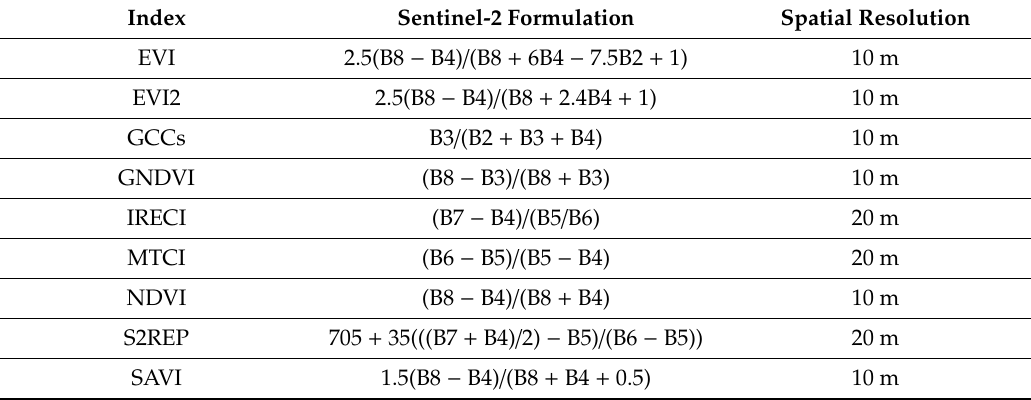
Table 1. Vegetation indices used in the study (listed alphabetically), formulation with Sentinel-2 bands and the available spatial resolution. Bands of Sentinel-2: B2 = blue, B3 = green, B4 = red, B5 = red edge 1, B6 = red edge 2, B7 = red edge 3, B8 = near infrared (NIR). EVI: Enhanced Vegetation Index; GCC: Green Chromatic Coordinate; GNDVI: Green Normalized Di ff erence Vegetation Index; IRECI: